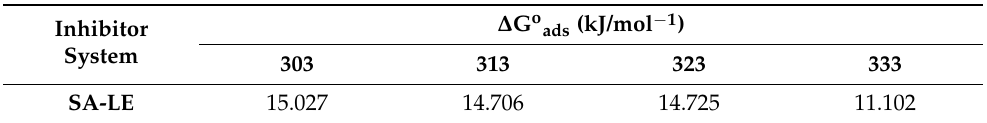
Table 7. Average free energy of adsorption parameters for inhibition effect of corrosion of mild steel at different temperatures in 1.0 M HCl for various concentrations of